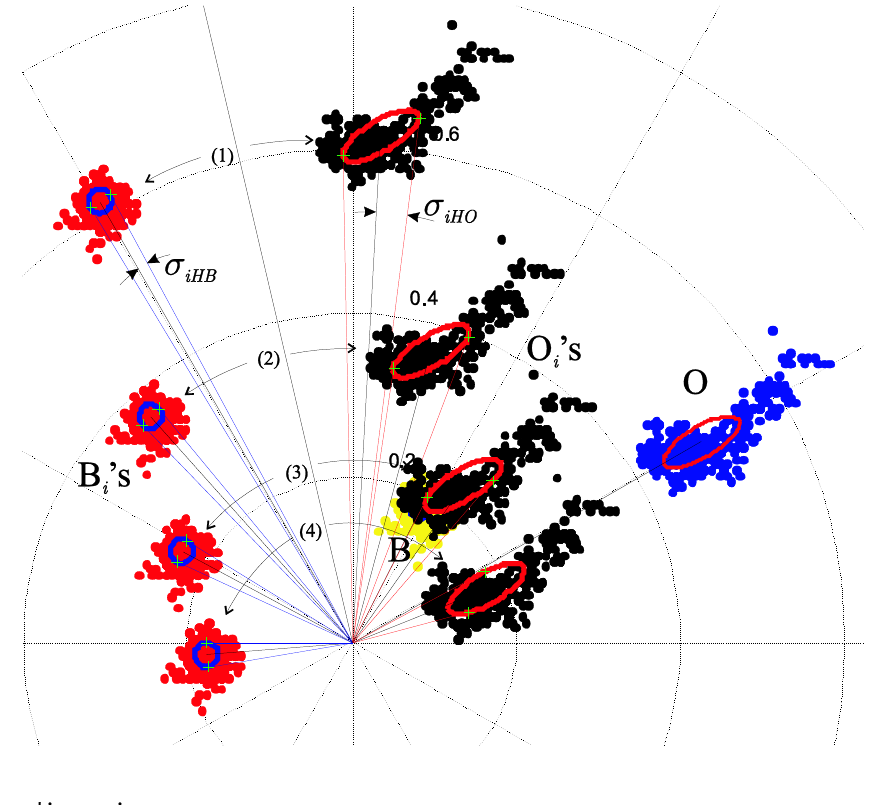
Figure 6. Location of the classes for 4 different separation angles (  ) in the polar HS i plane: (1)  = 33º, (2)  = 57º, (3)  = 97º, (4)  = 163º. The original classes (O and B) and i i i i the injected classes are shown for the 4 colour injections (O 's and B i i